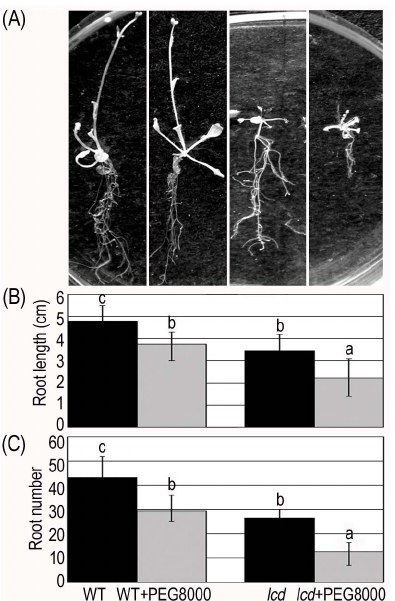
Figure 6. Root number and length in WT and lcd plants treated with PEG8000. ( A ) WT and lcd seedlings cultured in K MS and K MS containing PEG8000 for 26 day. ( B ) Length of roots. ( C ) Number of roots. Results are shown as mean 6 SE (n=3 independent exper- iments). Letter numbers indicate significant differences ( P , 0.05 ).